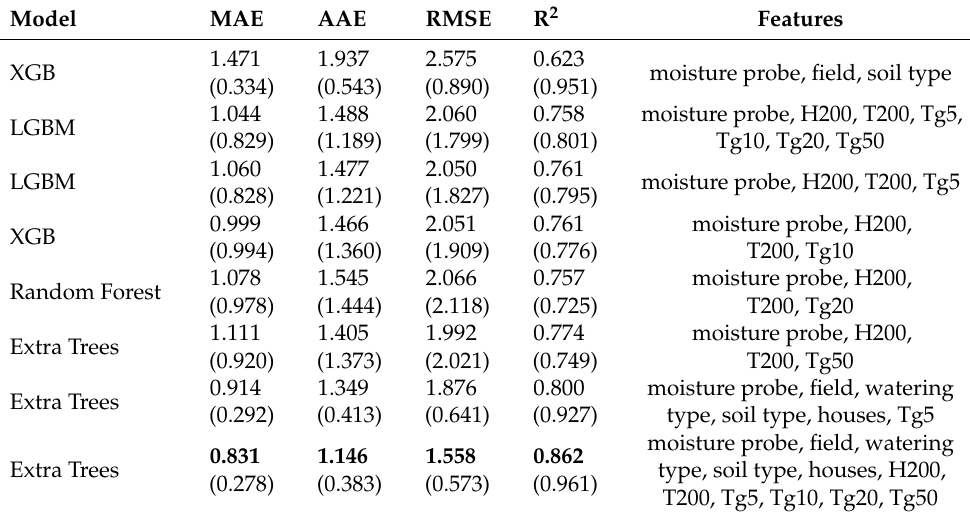
Table 3. Performance of the different models trained using different training sets comprised of several features’ configurations. For each set, the best performing model architecture, characterized by the lowest median absolute error, is listed in the first column. Metrics that are listed in brackets were determined using the training set. The best results are in bold